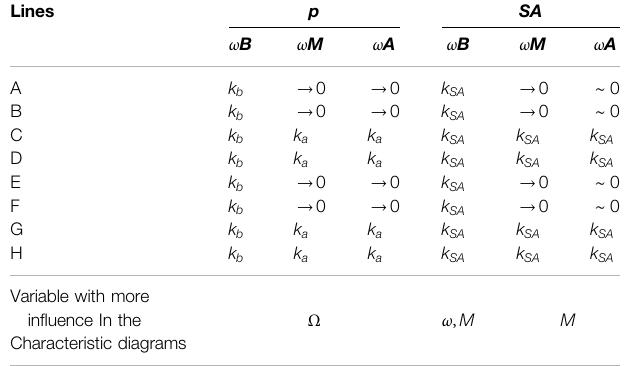
TABLE 6 | FD line diagram for the p and SA cases.